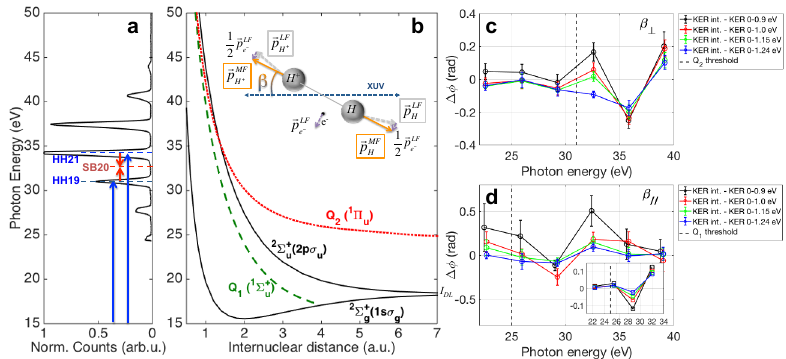
Fig. 1 H 2 dissociative photoionization . a) Example of an XUV spectrum used to perform the experiments in H 2 . b) Representation of the relevant potential energy curves as a function of the internuclear distance. For photon energies above 25 eV the Q 11 Σ u+ state is dominantly populated, while the Q 21 Π u appears only for absorbed energies above 32 eV. On the top right a schematic representation of the ion momenta is reported, passing from the laboratory frame (LF, grey dashed arrows) to the molecular frame (MF, orange solid arrows) by summing half of the electron momentum (black dashed arrow). The resulting molecular orientation (solid grey line) with respect to the XUV polarization axis (blue dashed line) defines the β angle. c) and d) represent the relative molecular phases as a function of the photon energy corresponding to b and b // , respectively. The ⊥ black dashed lines indicate the Q 2 c), and Q 1 d) DES thresholds. Each experimental data point represents the weighted mean over a set of 8 independent measurements. The inset in the panel d) shows the ab initio calculations accounting for all interaction terms reproducing the experimental parallel